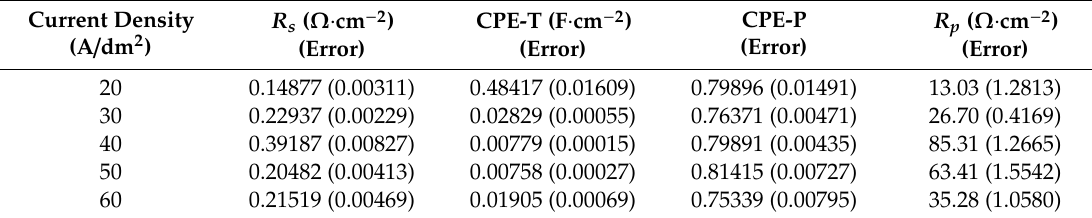
Figure 11. AC-impedance spectra of composite coating under di ff erent current density conditions. Table 6. Equivalent circuit parameter values and error.